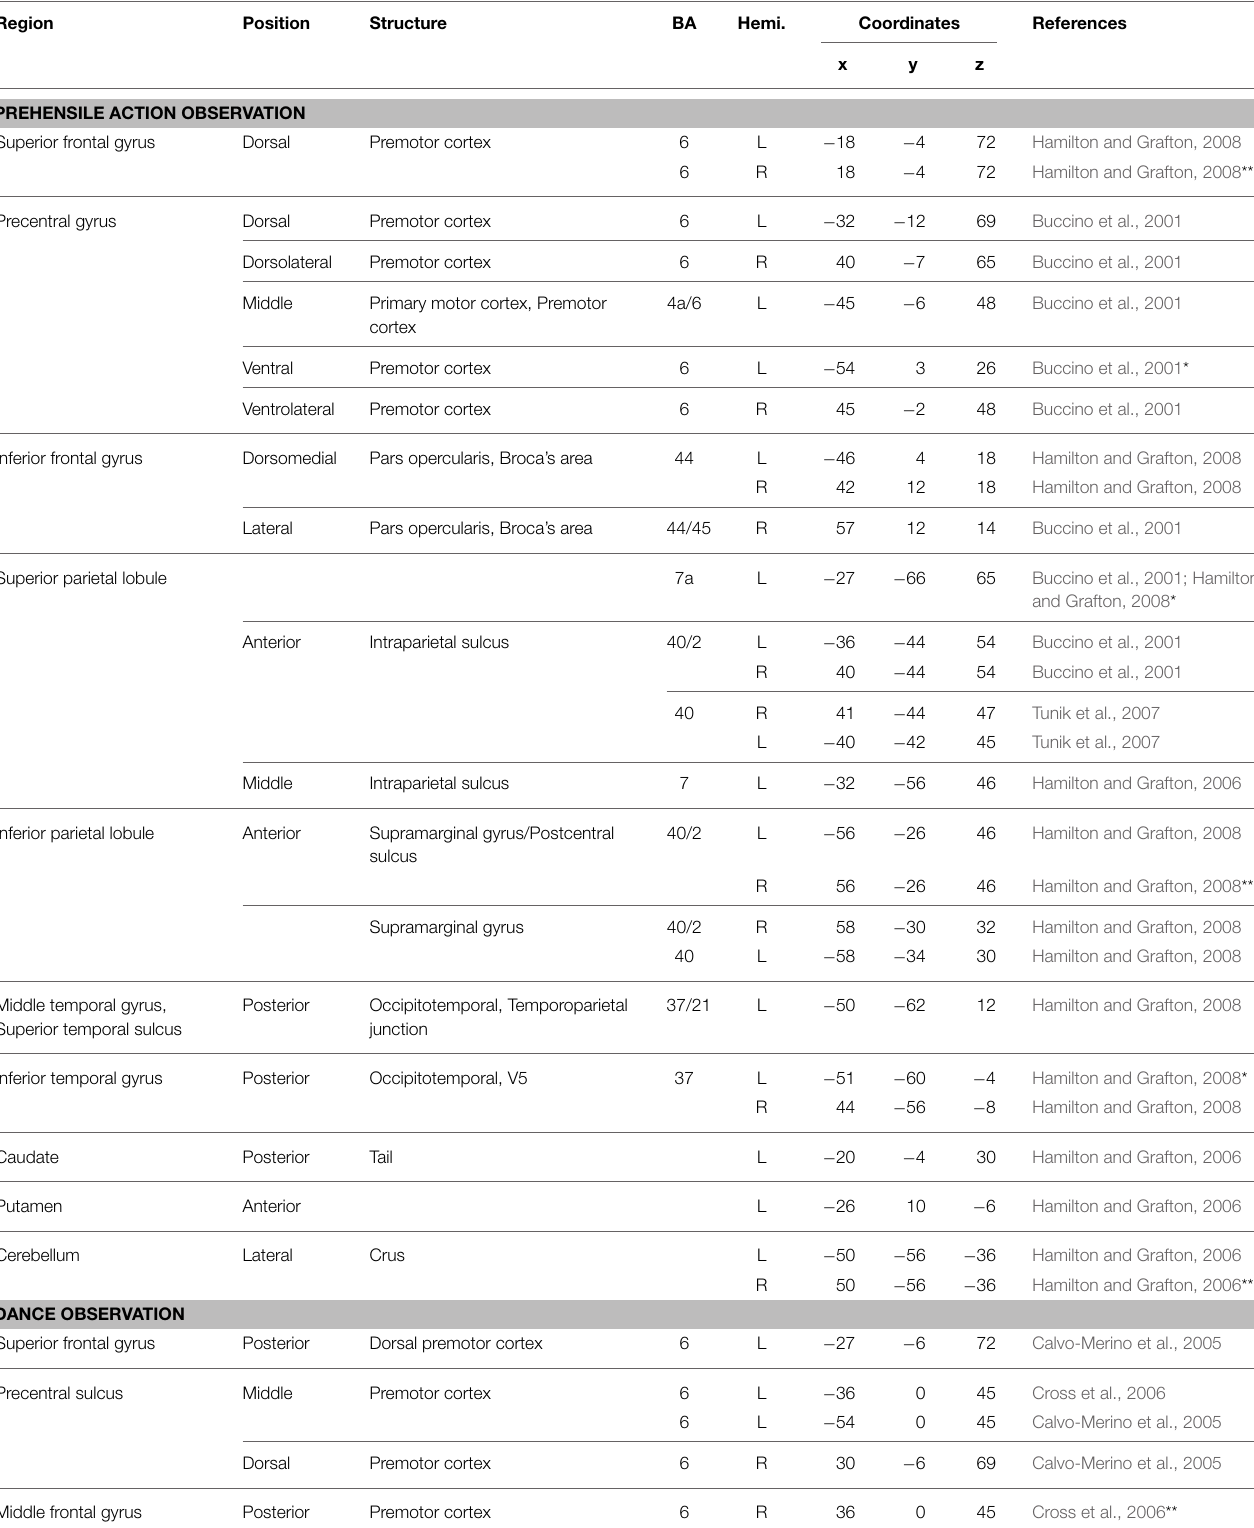
TABLE 1 | The action observation network, as defined by previous investigations. Region Position Structure BA